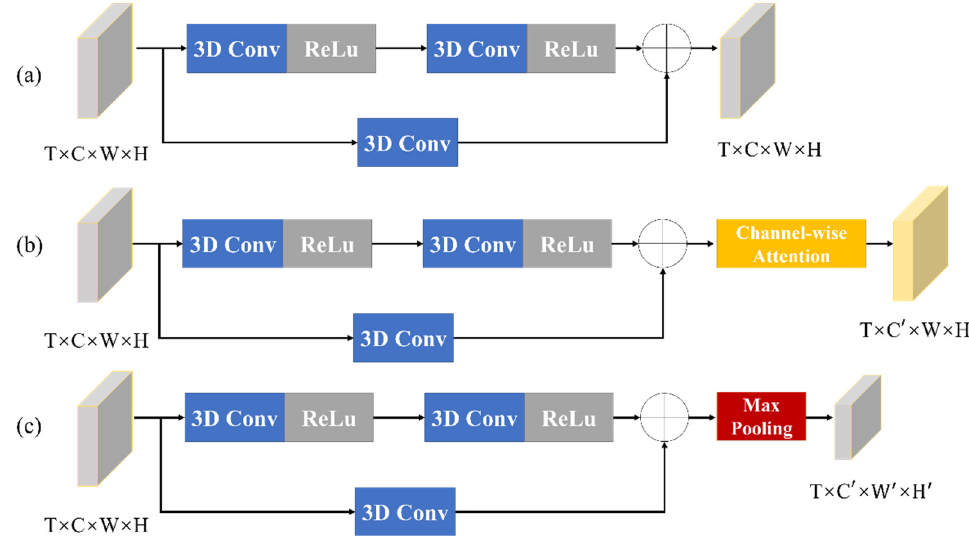
Figure 7. The structure of three subnets: ( a ) RefNet-Basic, ( b ) RefNet-Att, and ( c )